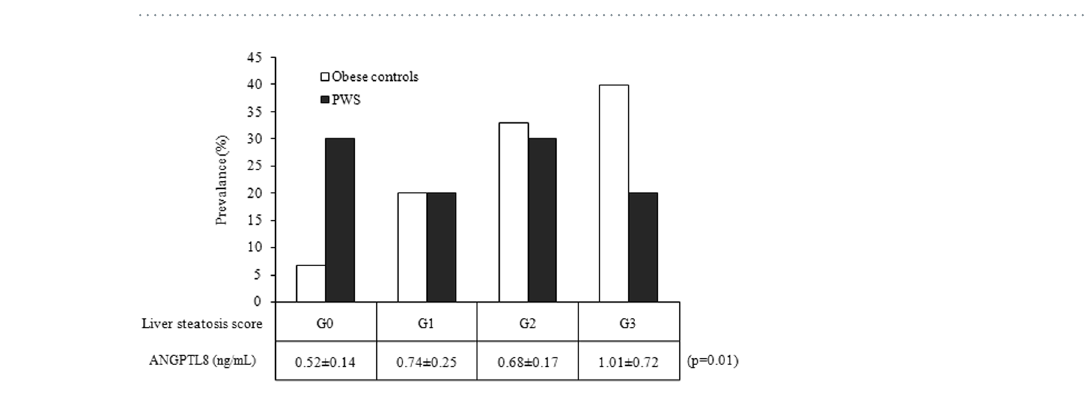
Figure 2. Individual values of circulating ANGPTL8 levels obtained in PWS patients and obese controls. Lines represent mean and standard deviation values in the two populations.